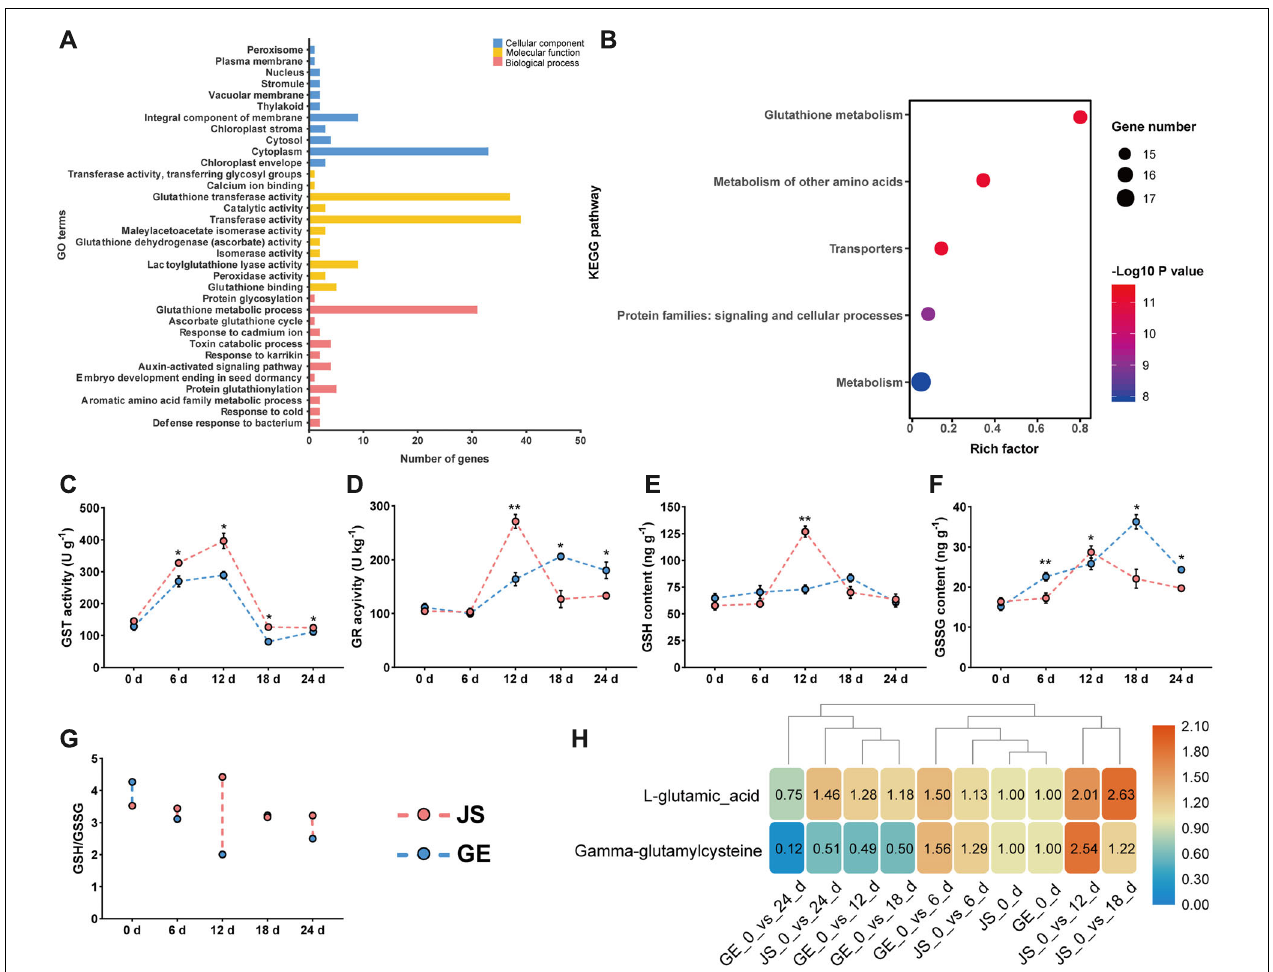
FIGURE 9 | Functional annotation of CmGSTs and detection of enzyme activities. (A) GO function annotation of 39 CmGSTs. (B) KEGG enrichment scatterplot of 28 stress-related CmGSTs. Activities of (C) GST and (D) GR, contents of (E) GSH and (F) GSSG, ratio of (G) GSH/GSSG, and contents of (H) L -glutamic acid and gamma-glutamylcysteine of JS and GE under cold stress during storage. Values are means ± standard error of three replicates. The error bars represent standard error of the means. The asterisk indicates significant difference (* P < 0.05, ** P < 0.01) among cold treatment for the same sampling